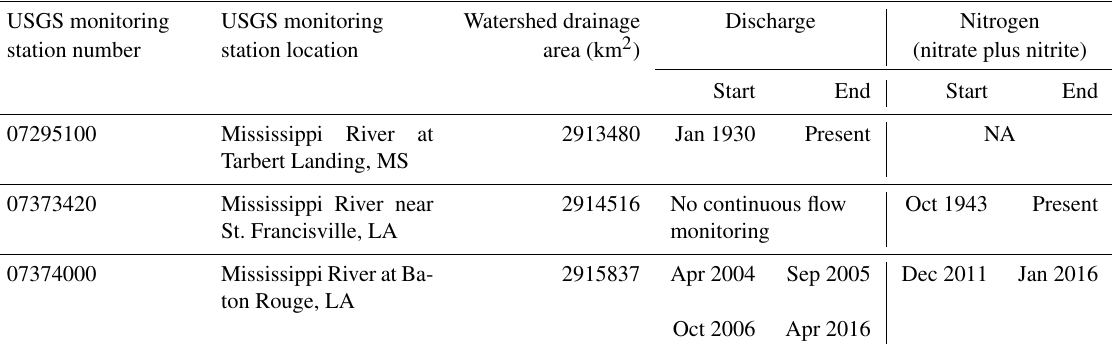
Figure 2. Geographic location of the Mississippi River basin (MRB): black dots with a cross indicate the USGS stations, located close to the outlet of the MRB and used to evaluate models’ performance; the black dot with a star indicates the outlet of the MRB. Table 3. USGS monitoring stations close to the outlet of the MRB; size of the drainage area; and the time period for available discharge, sediment, and nitrogen